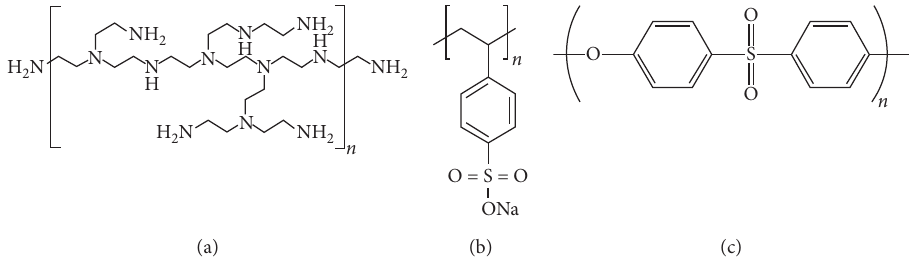
Figure 1: Molecular structures of materials used to synthesize PEM TFC membranes: (a) PEI, (b) PSS, and (c)